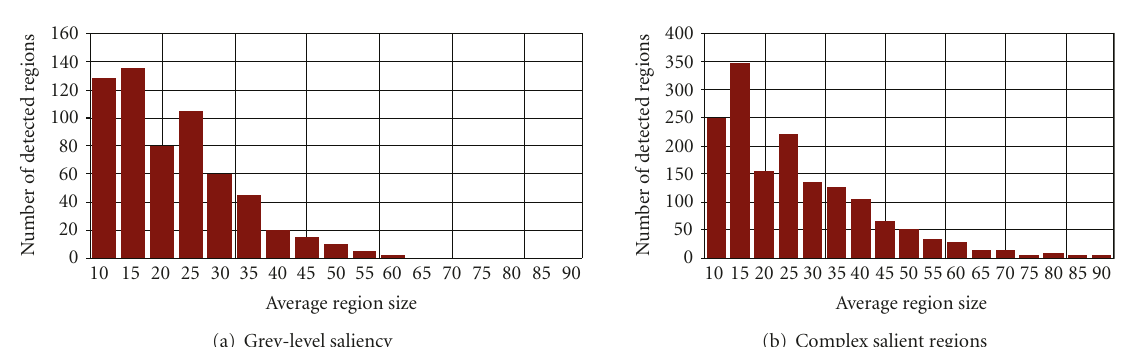
Figure 8: Histograms of mean region size and number of detected regions for the samples of Figure